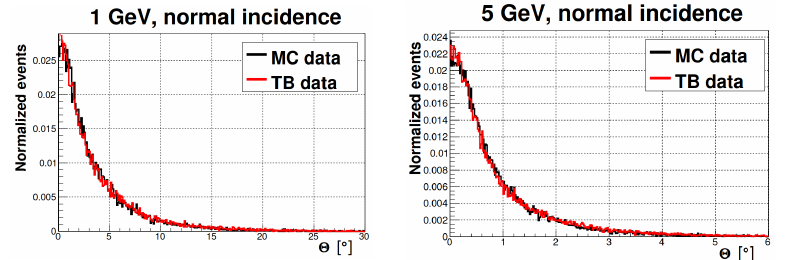
Figure 6. Angular resolution of the reconstructed tracks for 1 and 5 GeV electrons (from [7]).